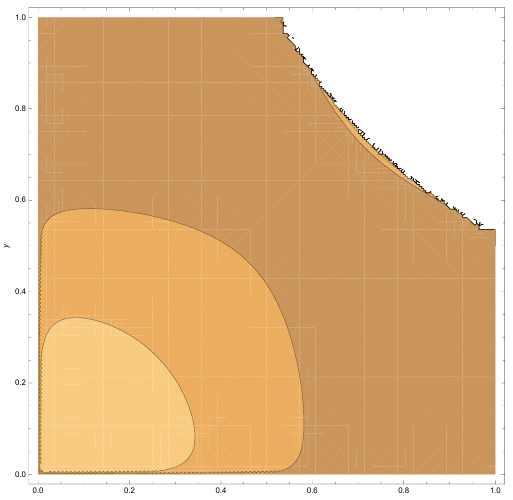
Figure A17. The bivariate Kumaraswamy density (Equation (1)) plot, where α = 1.1, β = 1.1, θ = 2 and δ = 0.8.